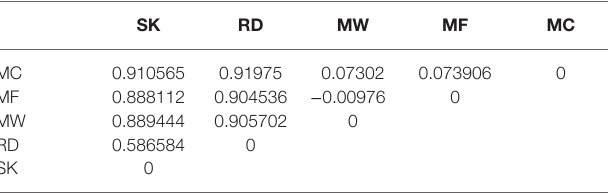
TABLE 2 | The genetic differentiation index between populations base on F ST .